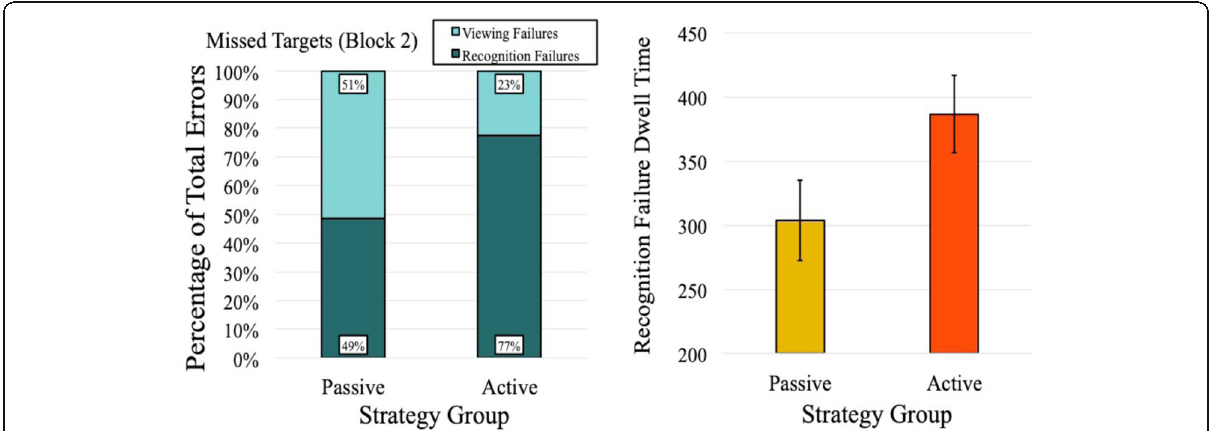
Fig. 6 Examination of target misses from experiment 2, derived via eye tracking. The left panel shows the distribution of viewing to recognition failures (across strategy groups). Note that the figure shows proportion of error types, not overall error rates (which varied across groups and were higher for passive searchers). The right panel shows target dwell times when recognition failures occurred. Error bars represent one standard error of the mean